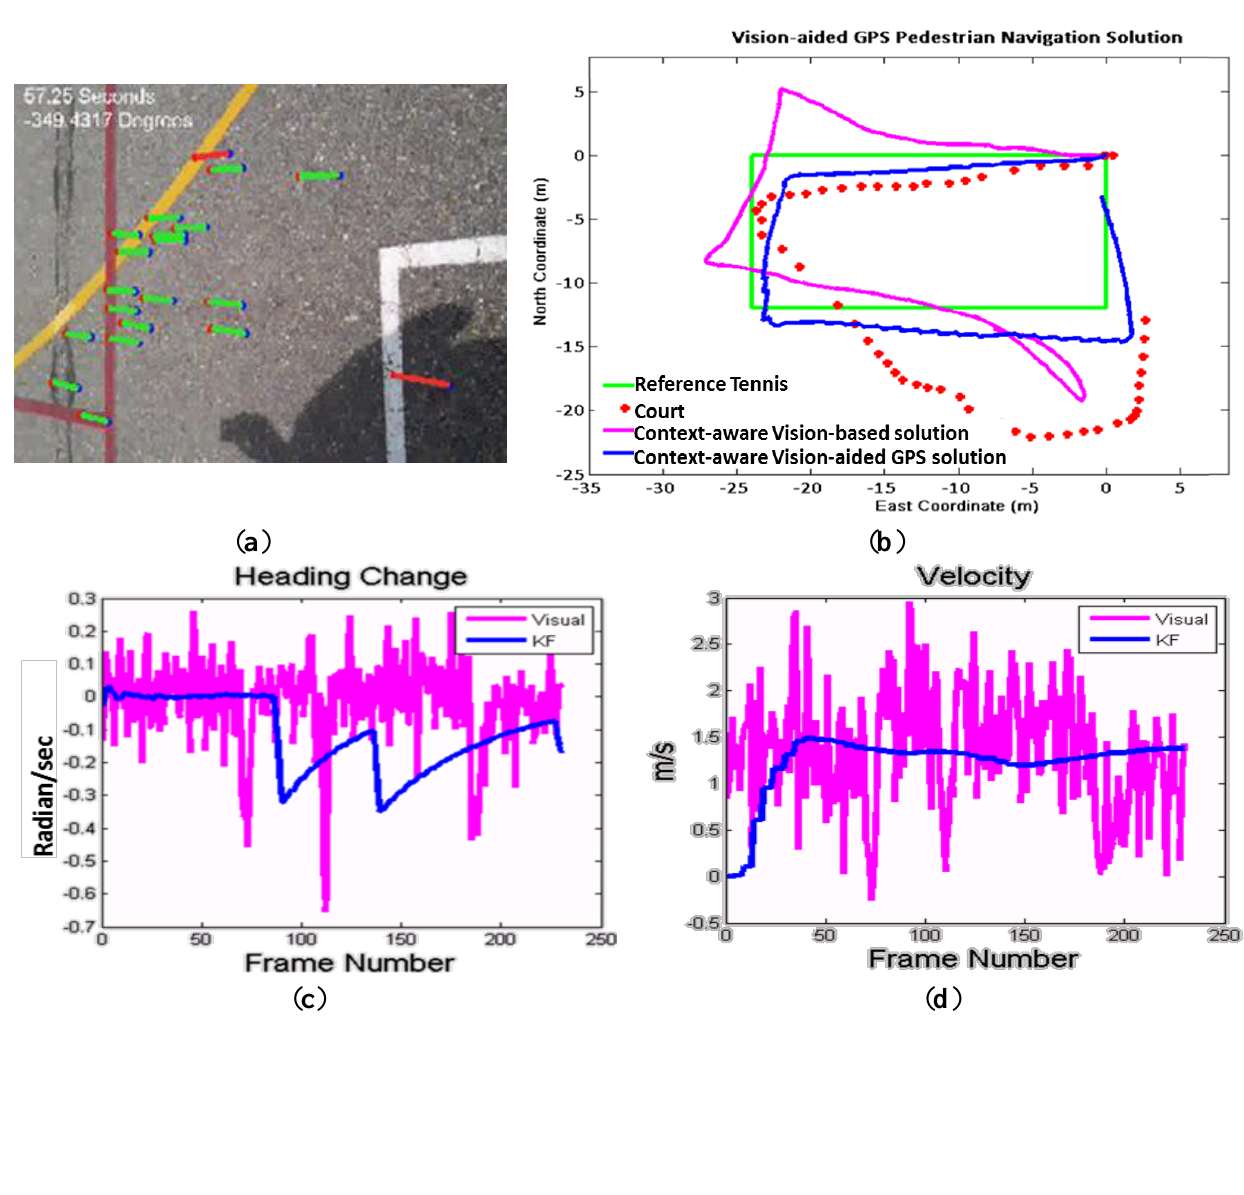
Figure 13. Vision aided GPS navigation: ( a ) An extracted video frame; ( b ) Vision-aided GPS in comparison with vision-based and GPS-only solution; ( c ) Heading angle changes estimated from visual sensor and KF; ( d ) velocity estimation using visual sensor and